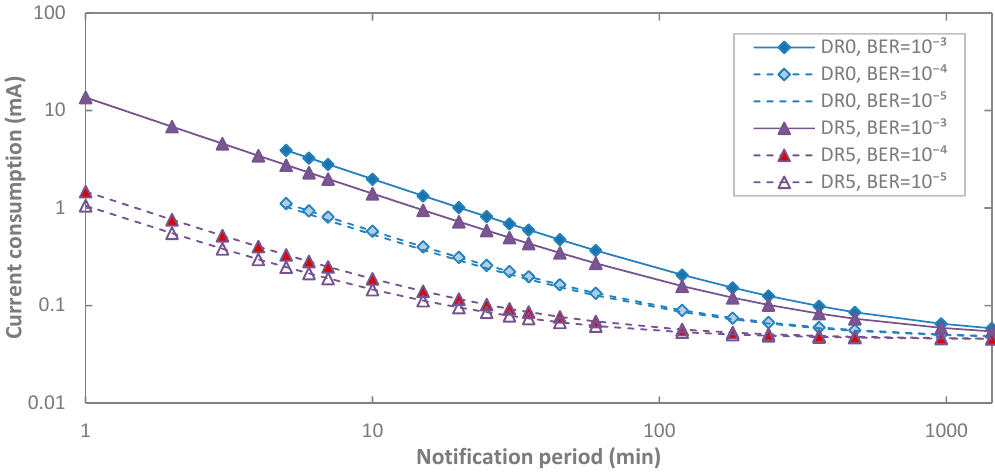
Figure 11. Impact of Bit Error Rate (BER) on the average current consumption of the end-device in acknowledged transmission, as a function of T Notif , for different DR settings and for p coll = 0.